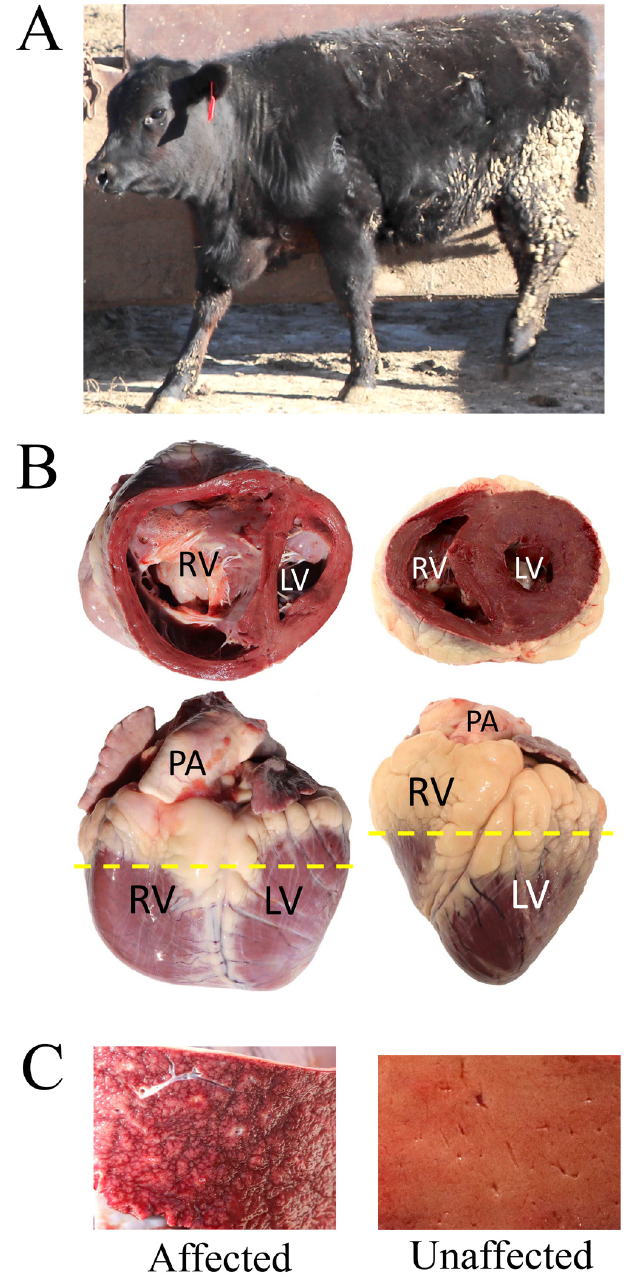
Figure 2. Gross morphological differences of a heart and liver in a representative bovine congestive heart failure (BCHF) clinical case. Panel A , affected heifer from (pair 77, Table S1) fattened at 1,200 m. Panel B , Gross heart morphology of affected heifer from pair 77 (left) and an unaffected Angus cow maintained for breeding at 578 m (right). The dashed line denotes where each heart was sectioned to show the dorsal half. Abbreviations: RV, right ventricle; LV, left ventricle; PA, pulmonary artery. Panel C , cross- section of the respective livers.